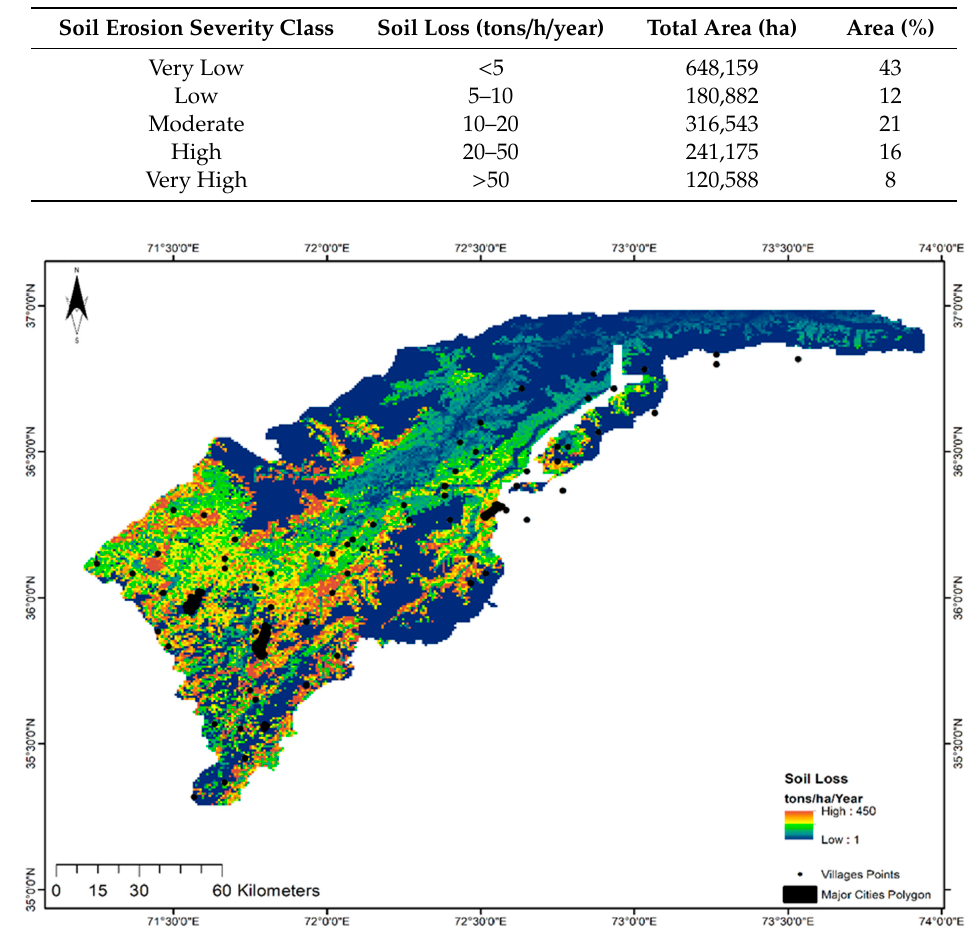
Table 3. Severity classes and area covered by these classes in the Chitral district.